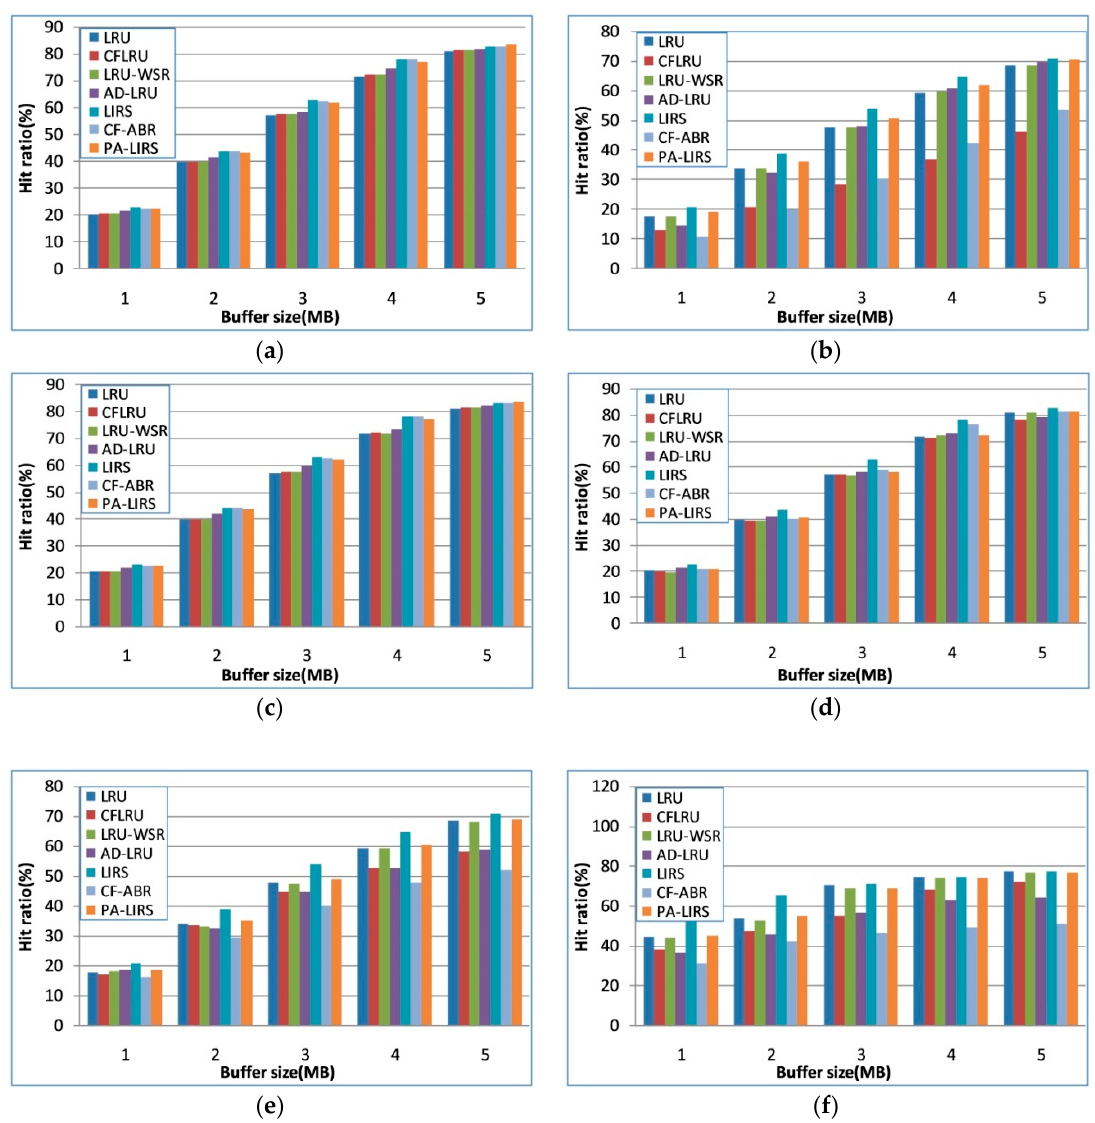
Figure 7. The bu ff er hit ratios of the di ff erent algorithms under 6traces. ( a ) T1 trace, ( b ) T2 trace, ( c ) T3 Figure 7. The buffer hit ratios of the different algorithms under 6traces. ( a ) T1 trace, ( b ) T2 trace, ( c ) trace, ( d ) T4 trace, ( e ) T5 trace and ( f ) OLTP T3 trace, ( d ) T4 trace, ( e ) T5 trace and ( f ) OLTP trace.